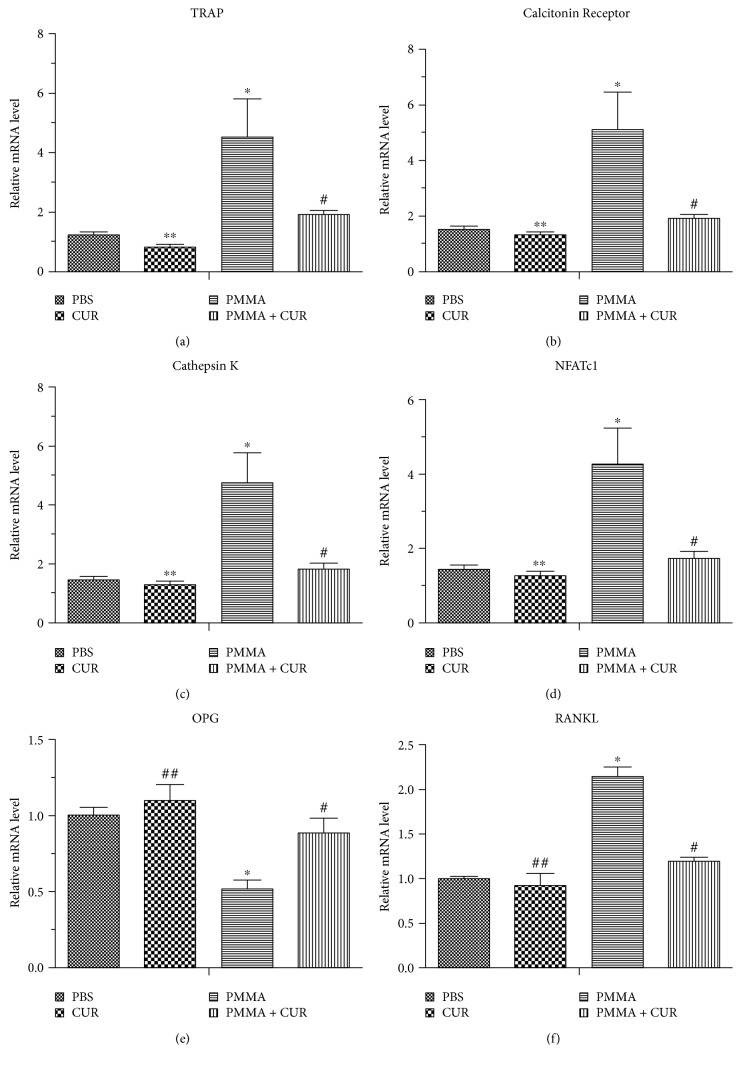
The mRNA levels of TRAP, CTR, CK, NFATc1, OPG, and RANKL were analyzed by RT-PCR, and the results were normalized to the expression in the PBS groups (N = 6/group; ∗∗p > 0.05 versus the PBS group; ##p < 0.05 versus the PBS group; ∗p < 0.001 versus the PBS group; #p < 0.01 versus the PMMA group).